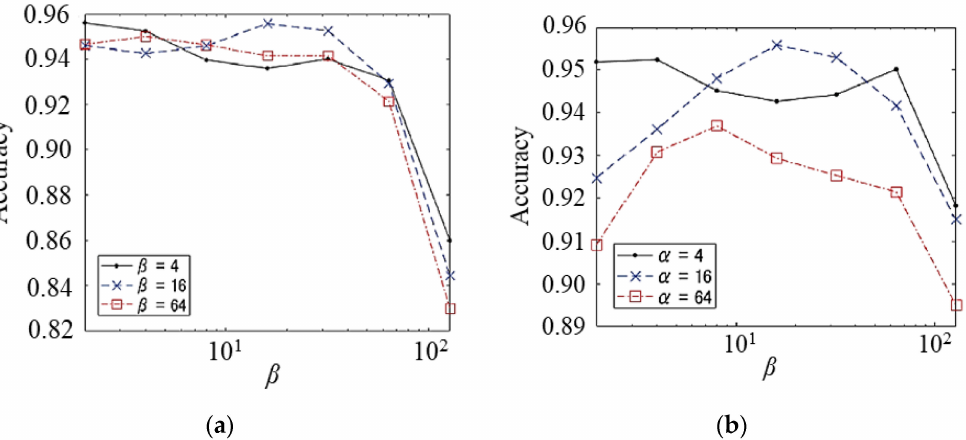
Figure 9. Identification accuracies using SPWVD for various parameters ( N = 25). Relationships between accuracy and ( a ) α , ( b ) β .